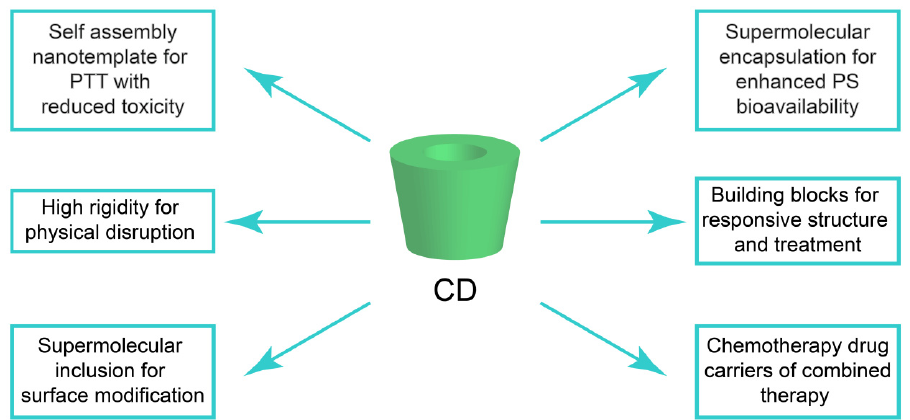
Figure 1. CD functionalities in tumor phototherapy